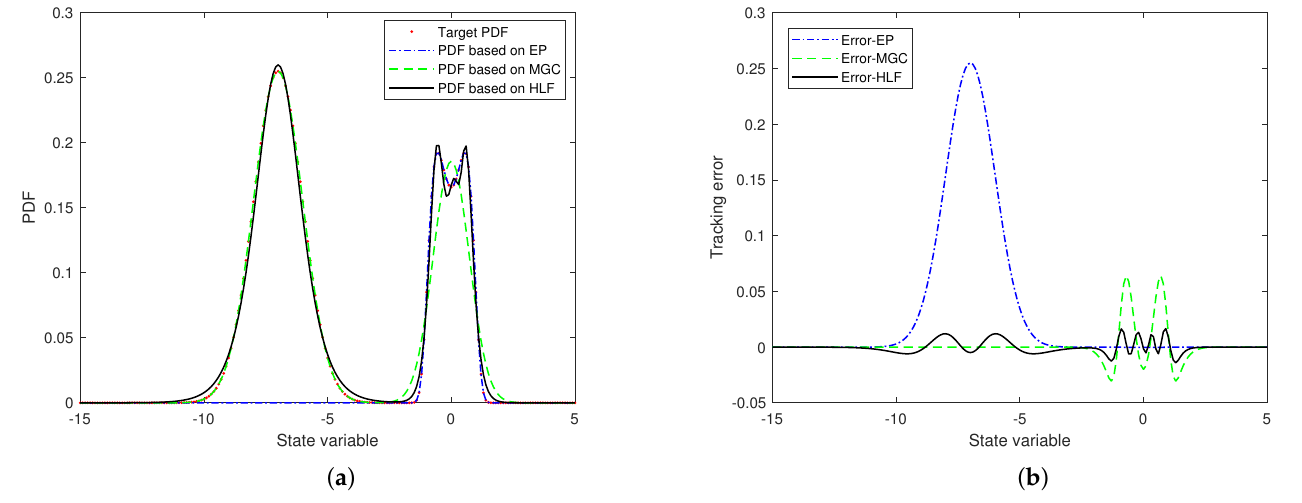
Figure 4. Case 4: Complex trimodal target PDF. ( a ) Control effect. ( b ) Tracking